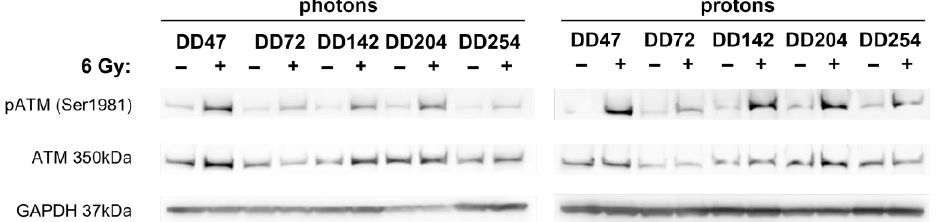
Figure 5. Radiation-induced activation of ATM kinase in CRC PDOs. Western blot analysis of CRC PDOs 4 h post photon and proton irradiation for (phosphorylated) ATM. GAPDH served as loading control.